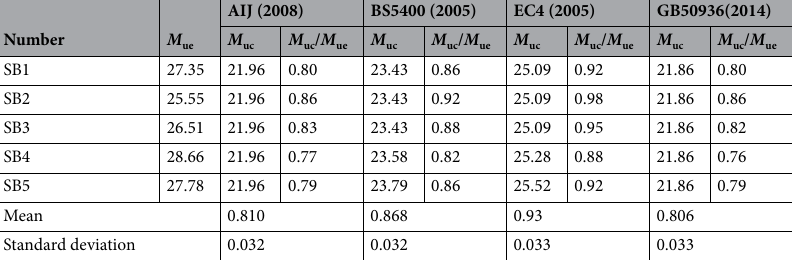
Table 4. Comparison of calculated values with test values.